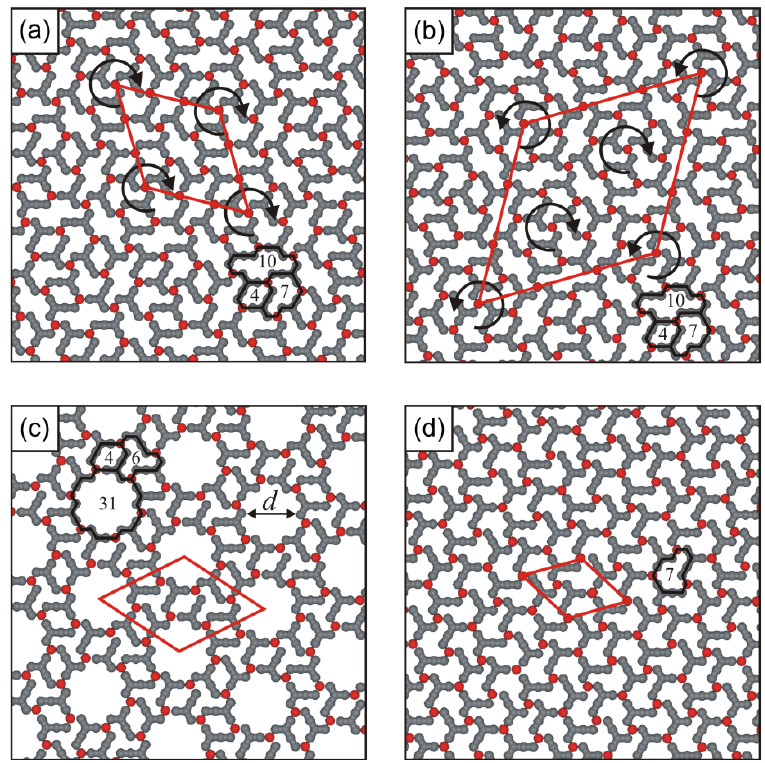
Figure 7. Small fragments of artificially created metal–organic overlayers composed of ligands F and trivalent metal atoms. The solid red lines delimit unit cells of the crystalline supramolecular patterns. The solid black lines mark the edges of empty nanopores differing in size and shape. Inside the highlighted nanopores the numbers of empty adsorption sites are given. ( a , b ) The flower-like networks with density (cid:2025) = 0.533 and rhombic unit cells differing in side lengths: (cid:3435)√117 × √117 ∠ 60/120 (cid:2925) (cid:3439) and (cid:3435)√234 × √234 ∠ 60/120 (cid:2925) (cid:3439) . The black curved arrows denote a handedness of individual closed rosettes; ( c ) the multiporous phase with a rhombic unit cell (cid:3435)√91 × √91,∠ 60/ 120 (cid:2925) (cid:3439) and density (cid:2025) = 0.457 ; ( d ) the homoporous phase with a rhombic unit cell (cid:3435)√39 × √39,∠ 60/120 (cid:2925) (cid:3439) and density equal to (cid:2025) = 0.533 .